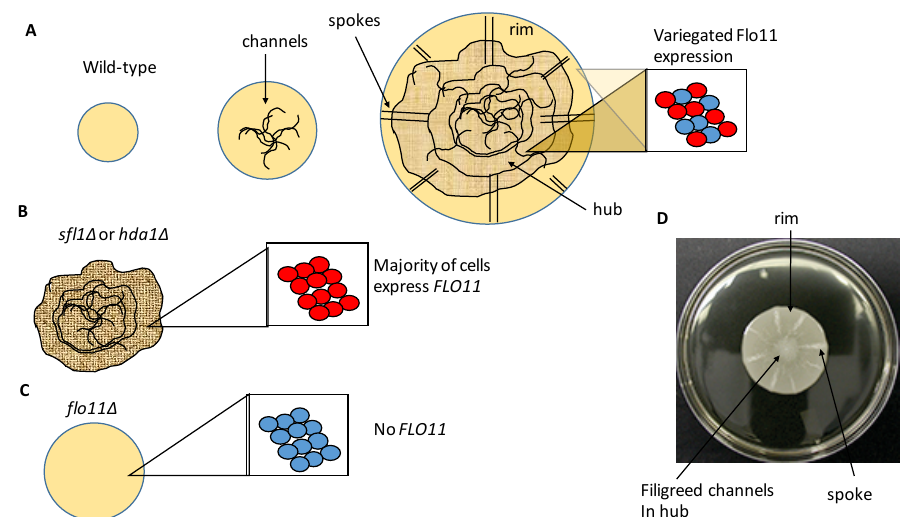
Figure 2. Mat formation is accompanied by the formation of channels that are correlated with variegated expression of Flo11. ( A ) A cartoon describes the formation of channels that correlate with cell adhesion during mat formation in wild-type and how some of these channels reach the edge of the mat and are referred to as spokes. The smooth edge of the mat lacks channels is referred to as the rim. (inset: cells from both the rim and hub appear to have variegated expression of Flo11 where red cells express Flo11 and blue do not express Flo11). ( B ) The sfl1 ∆ and hda1 ∆ mutants both exhibit expression of Flo11 by the majority of cells (inset: all red cells), and this correlates with them acting like hub cells with no rim and not spreading well. ( C ) A flo11 ∆ mutant looks more like a large rim with no hub and all cells lack Flo11 (inset: all blue cells). ( D ) A photo of a wild-type mat is shown and the different structures are shown to put the wild-type cartoon in ( A ) in better